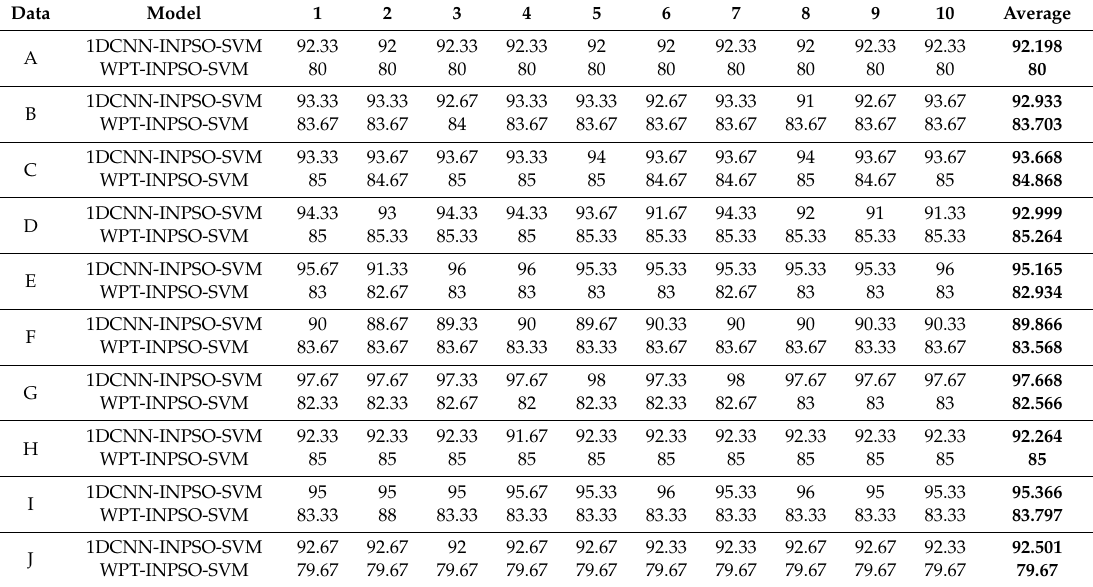
Table 6. Recognition results of ten trials using di ff erent methods.